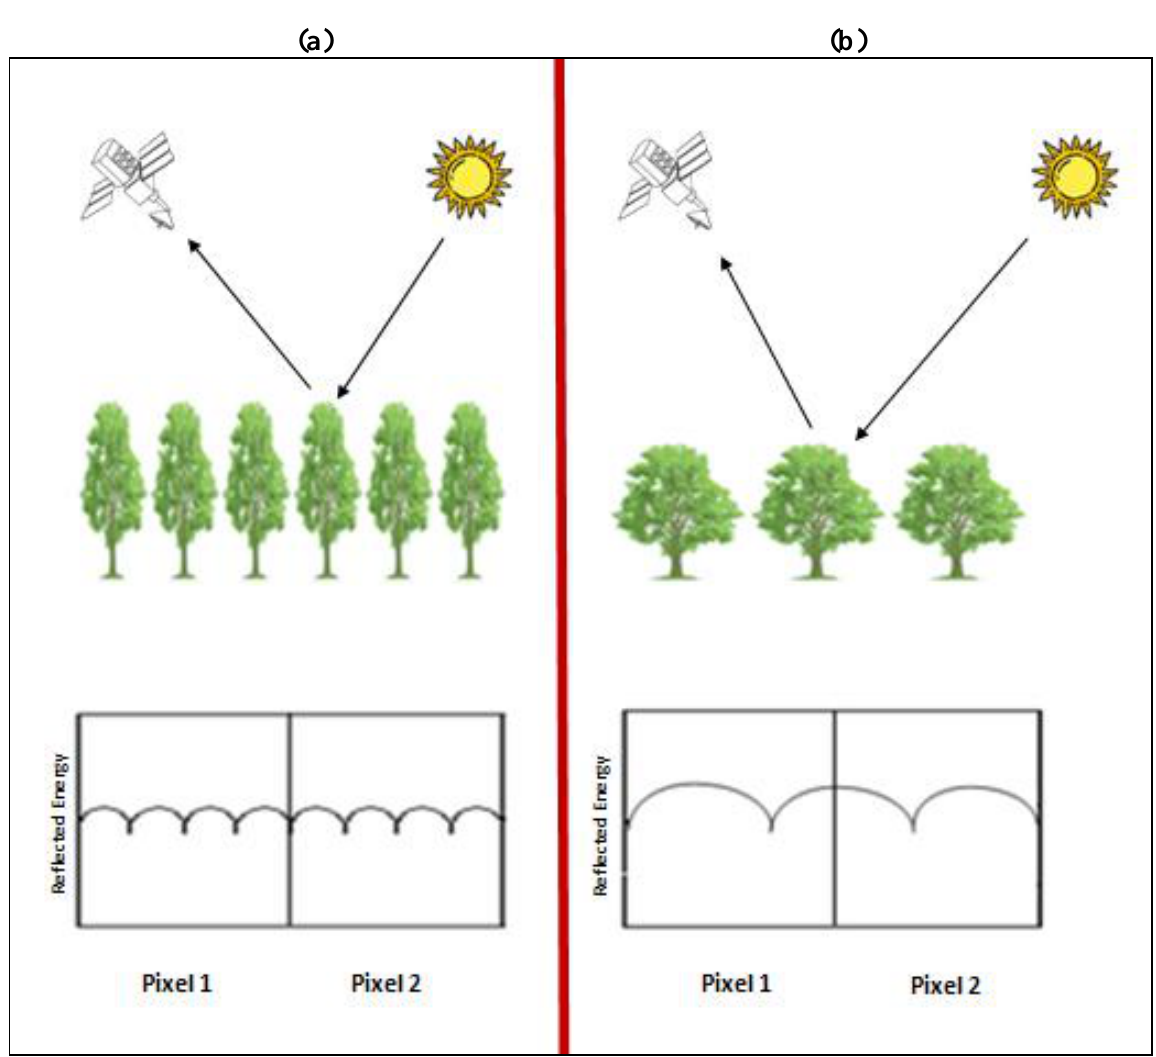
Figure 1. Size class effect on remotely sensed data: (a) small crown trees (b) large crown